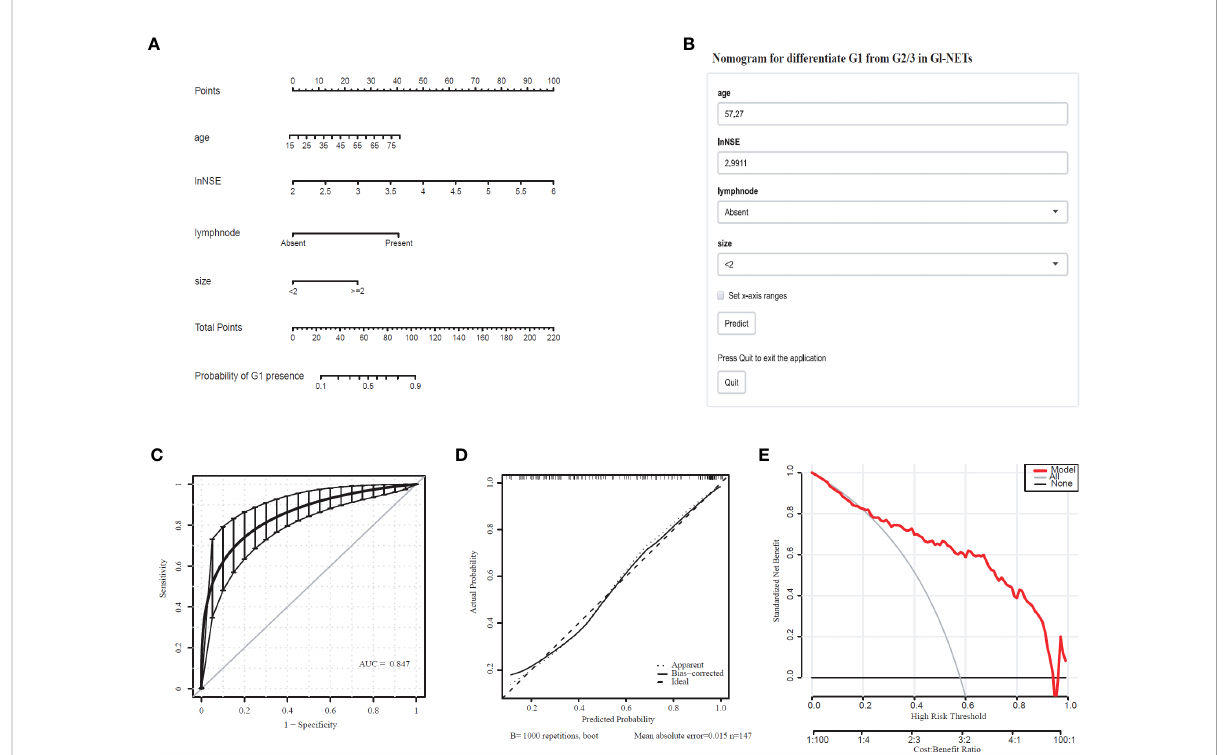
FIGURE 2 Nomogram for Preoperative Estimation of G1 Risk and Its Predictive Performance. (A) , Nomogram to estimate the risk of G1 presence in GI- NETs. (B) , corresponding online calculators to predict the risk of G1. Online tools are available at http://ginet.shiny.io/dynnomapp1/. (C) , Receiver operating characteristic ROC. (D) , the calibration curve and (E) , the decision